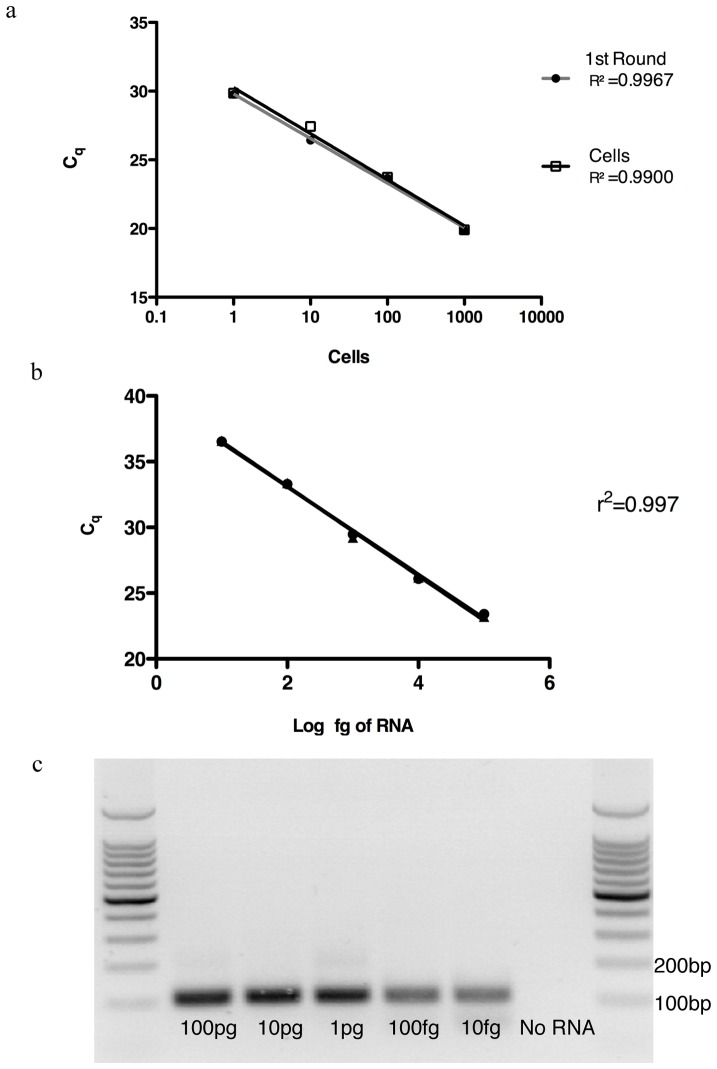
Assessment of reverse transcription efficiency and assay sensitivity.A) CD25+ CD134+ CD4 T cells were sorted 1000, 100, 10 and 1 cell. All cell number was reverse transcribed under the same conditions. The 1st round product (filled circle) of 1000 cells was then diluted to the appropriated concentrations corresponding to the cell numbers. 2nd round real-time amplification of ß-actin was then performed. A) The linear regression for the 1st round products and the cells (empty squares) were r2 = 0.9967; Slope =  −3.24, r2 = 0.9900; Slope =  −3.34 respectively. All replicates were performed in triplicate. B) Varying amounts of RNA from activated CD25+CD134+ CD4 cells were used in the multiplex single-cell RT-PCR assay from 100 pg to 10 fg. ß-actin expression (duplicate) is detectable at all levels and the reverse transcription of the assay is linear with r2 = 0.997. C) Representative gel from the same PCR run, with ß-actin specific band at 100bp. All replicates were performed in triplicate.